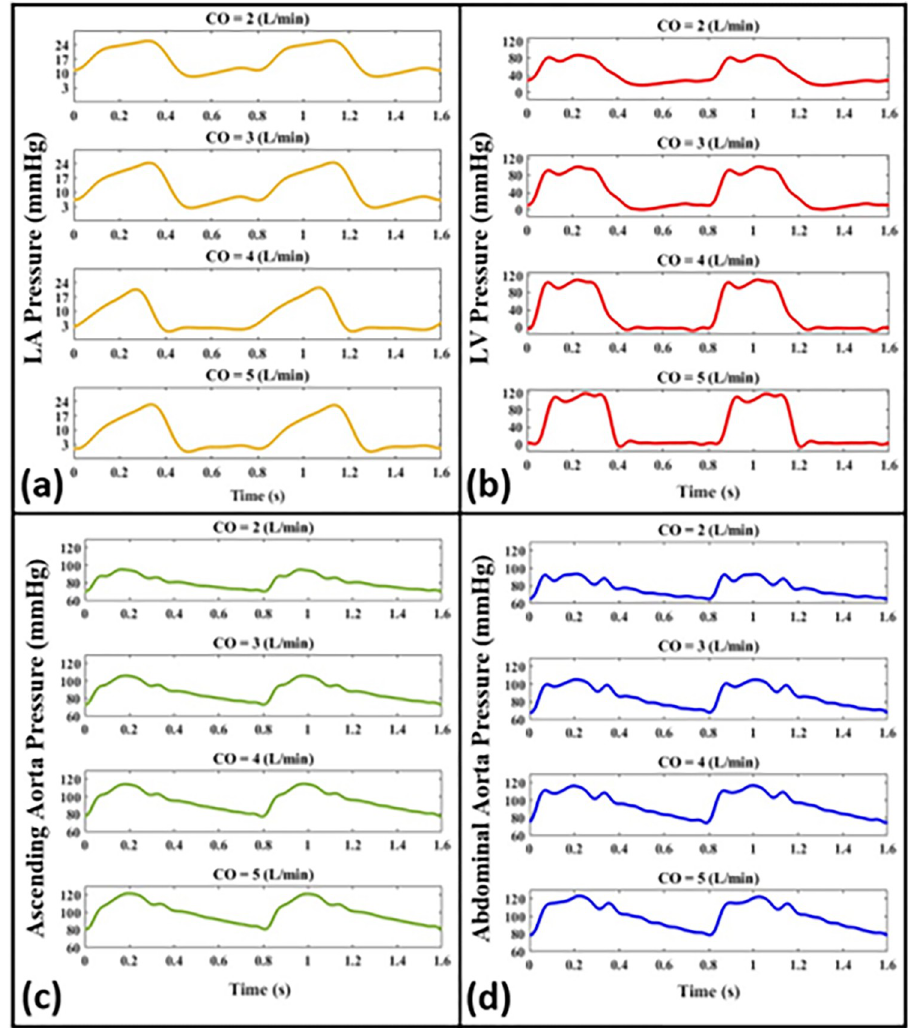
Fig 8. Pressure waveforms for normal ( CO = 5 L/min) and impaired ( CO = 2, 3, 4 L/min) conditions of cardiac function at different anatomical sites including (a) the left atrium, (b) the left ventricle, (c) the ascending aorta, and (d) the abdominal aorta. Waveforms are plotted for Aorta-3 at HR = 75 bpm and a fixed (normal)